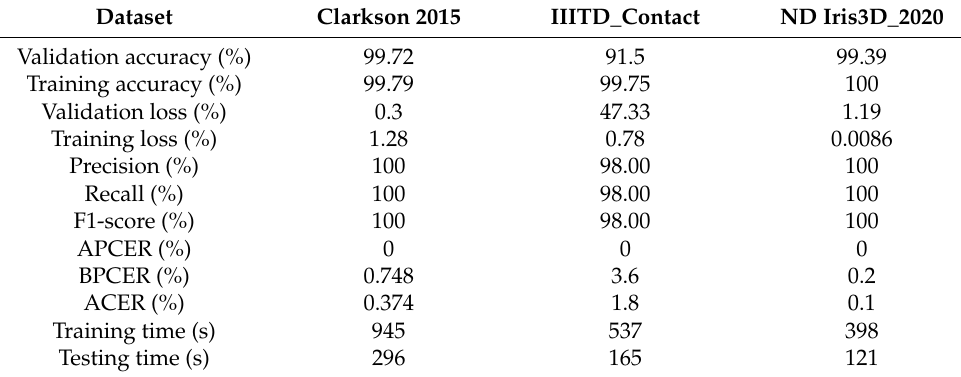
Table 6. Performance evaluation of the ResNet50 model for iris liveness detection.